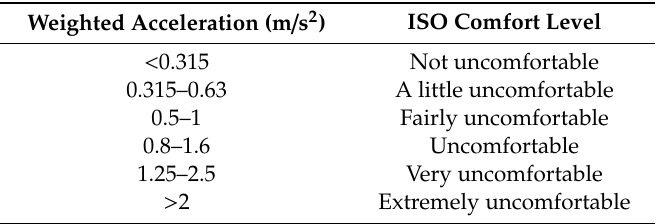
Table 1. Comfort level scales of the ISO standard